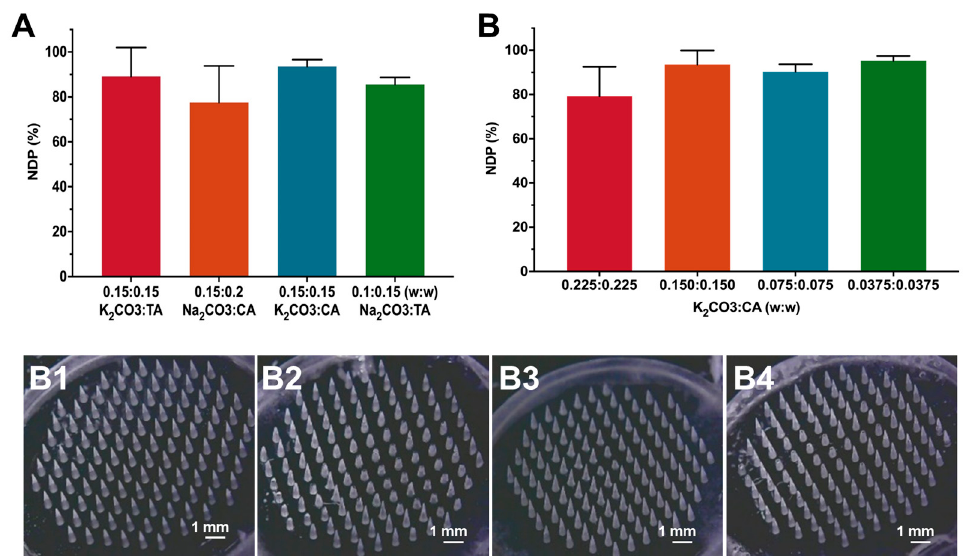
Figure 8. The in fl uence of pneumatic initiator compositions on the ( A ) DNP ( n = 3) and ( B ) morphology of particle-embedded gas-propelled MNs: ( B1 ) K 2 CO 3 :TA = 0.15:0.15, ( B2 ) Na 2 CO 3 :CA = 0.15:0.20, ( B3 ) K 2 CO 3 :CA = 0.15:0.15, ( B4 ) Na 2 CO 3 :TA = 0.1:0.15. ( C ) The in fl uence of the feeding concentration of K 2 CO 3 and CA on the DNP of MNs ( n = 3).